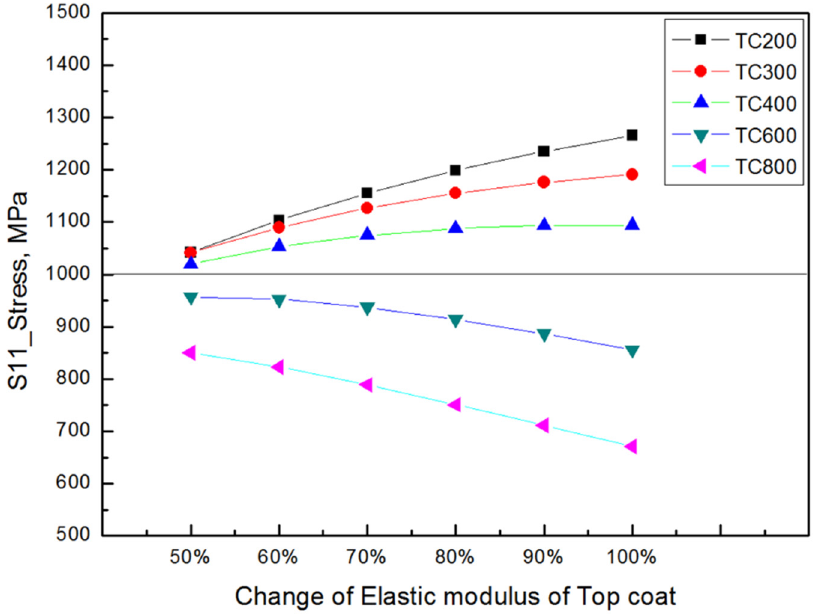
Figure 14. Stress variation according to the thickness of TBC.